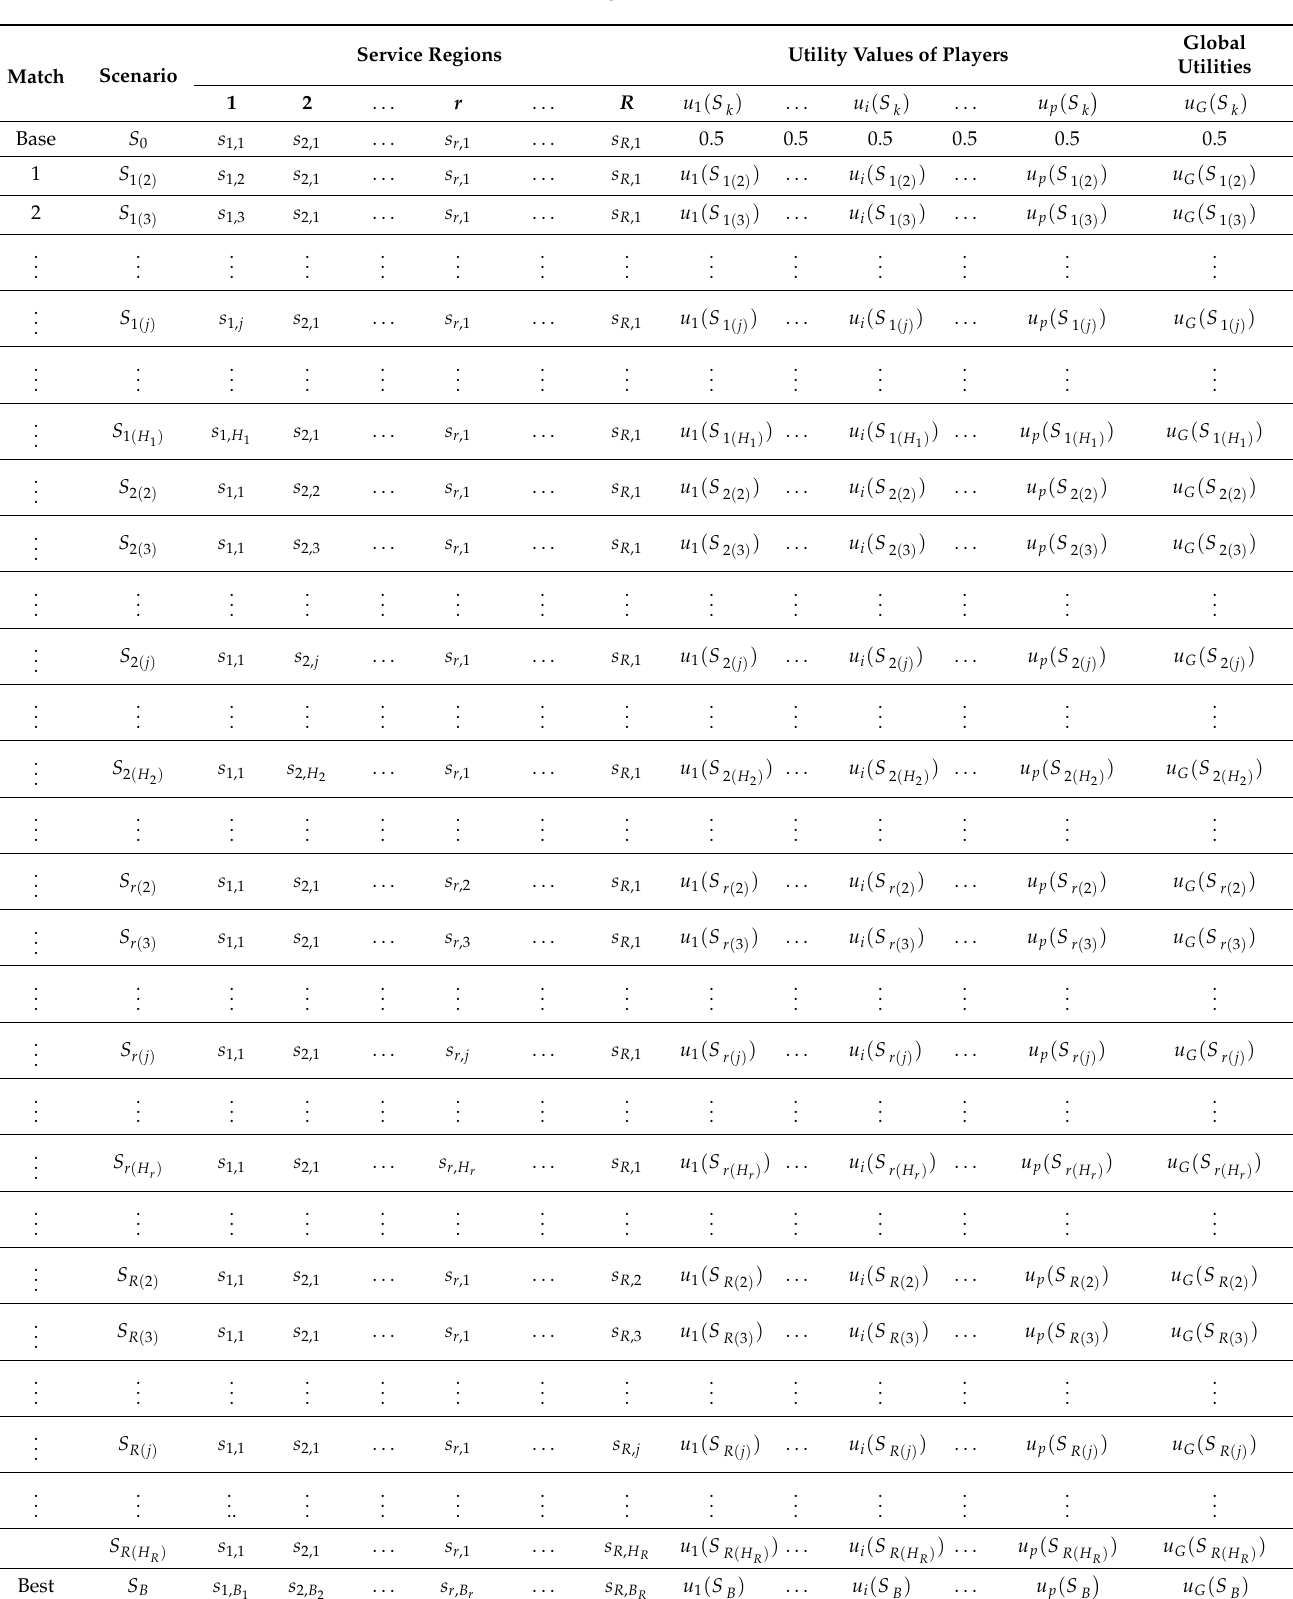
Table 7. Game scenarios and global